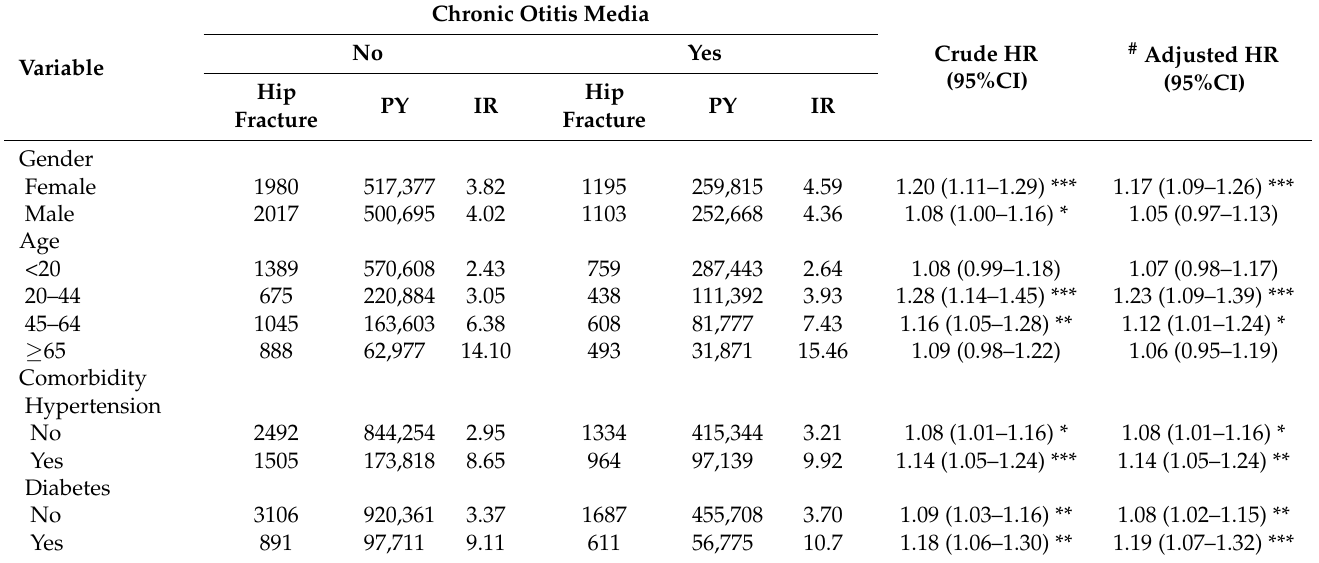
Table 3. Differential incidence rate and hazard ratio of hip fracture among the subjects with and without chronic otitis media stratified by gender, age, and comorbidities.